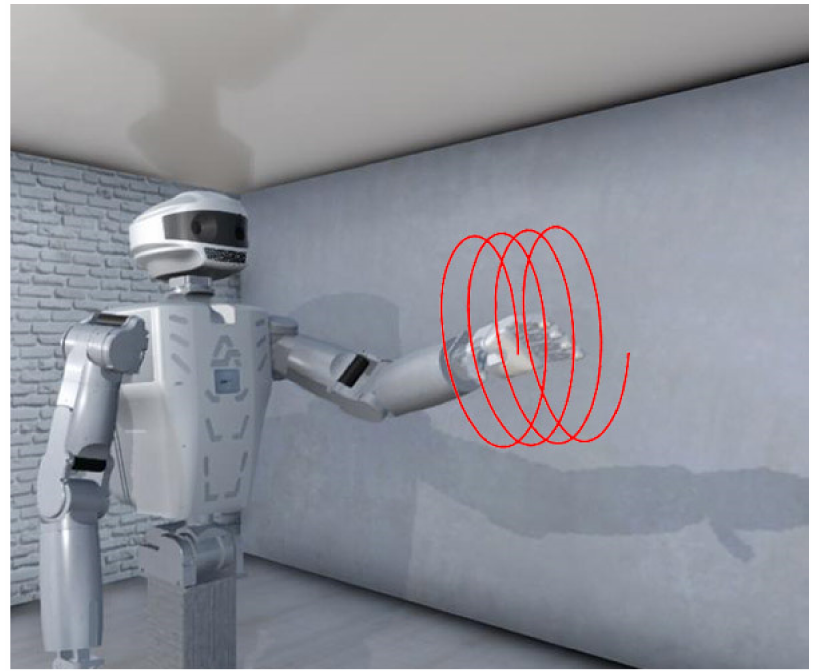
Figure 18. Testing the NN on the SAR-401